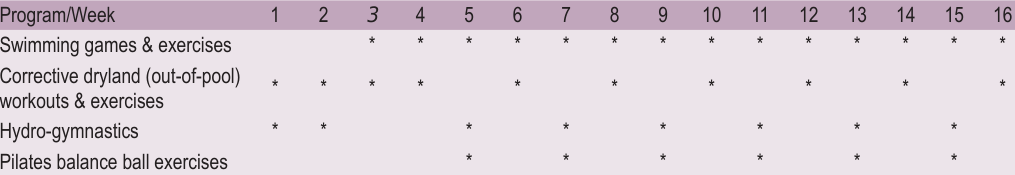
TABLE 4. Implementation of the programme contents by